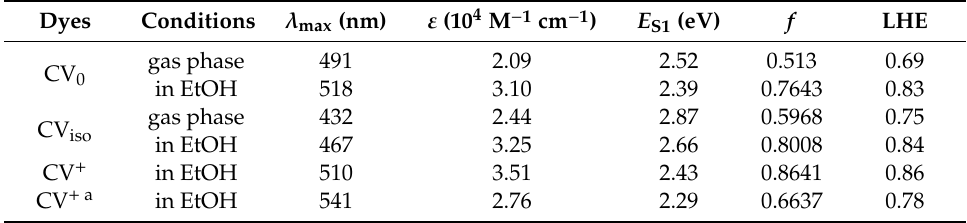
Table 1. Calculated maximum absorption peaks ( λ max ), molar absorption coe ffi cients ( ε ), energies of singlet excited states ( E S1 ), oscillator strengths ( f ) and light-harvesting e ffi ciencies (LHE) of CV 0 , CV iso and CV +